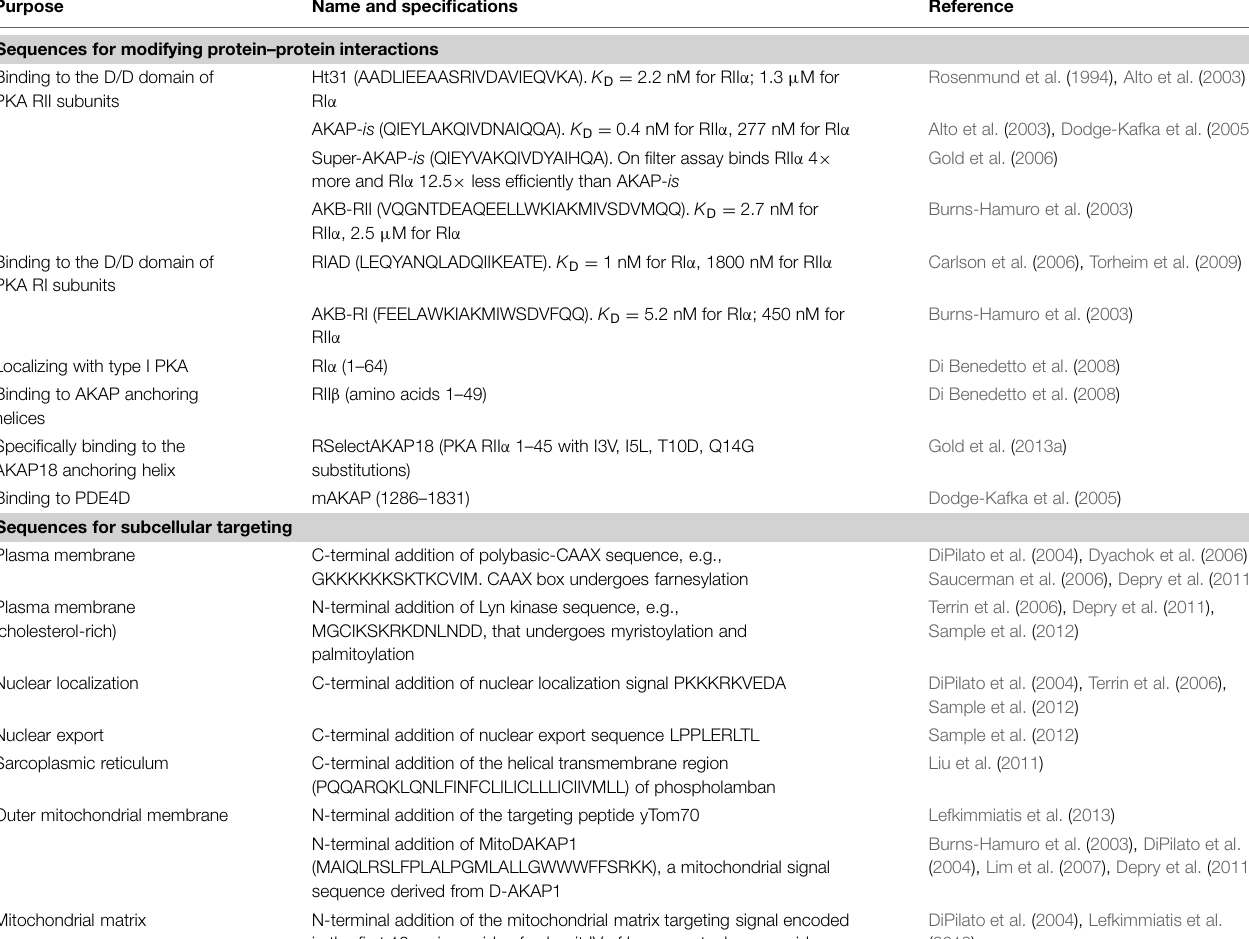
TABLE 1 | Sequences for modifying interactions between cyclic AMP (cAMP) signaling proteins and subcellular